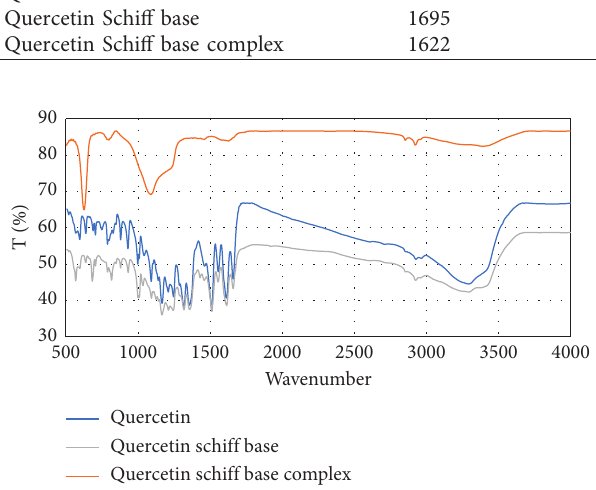
Figure 3: FT-IR spectrum of quercetin, quercetin Schiff base, and quercetin Schiff base complex.